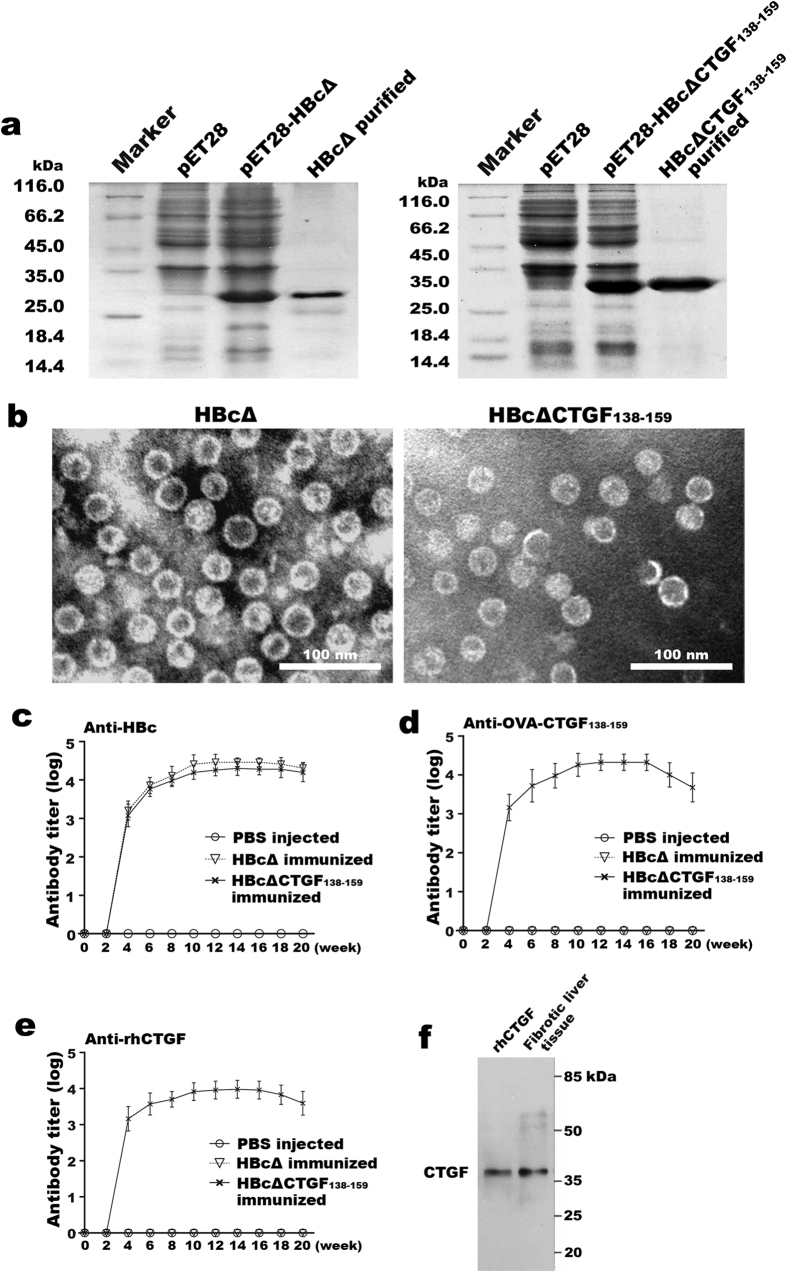
Recombinant protein HBcΔCTGF138-159 assembled into VLPs and elicited high titres of anti-CTGF antibodies in mice.SDS-PAGE followed by Coomassie brilliant blue staining verified the expression and purification of HBcΔ and HBcΔCTGF138–159 (a). Negative-staining electron microscopy revealed that both recombinant HBcΔ and HBcΔCTGF138–159 assembled into VLPs (b). Scale bars = 100 nm. After five immunizations with HBcΔCTGF138–159 or HBcΔ VLPs, the production of anti-CTGF and anti-HBc antibodies in the BALB/c mice was determined via ELISAs with plates coated with HBc (c), OVA-CTGF138–159 (d) and rhCTGF (e). Western blotting showed that the antiserum from the mice immunized with HBcΔCTGF138–159 recognized a 37-kD band in fibrotic liver tissue corresponding to rhCTGF (f). VLP, virus-like particle; SDS-PAGE, sodium dodecyl sulfate polyacrylamide gel electrophoresis; ELISA, enzyme-linked immunosorbent assay; OVA, ovalbumin; rhCTGF, recombinant human connective growth factor.